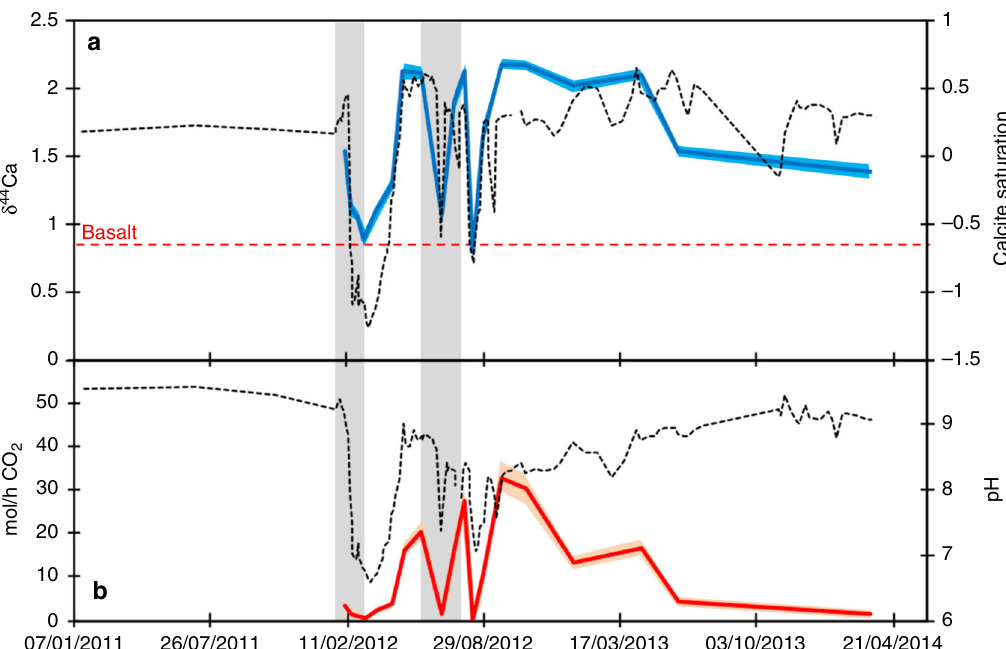
Fig. 3 The trends of the calcite saturation state and Ca isotopes with time during the carbon injection phase from monitoring borehole HN-4. a Ca isotope ratios (blue line) and calcite saturation index (dotted black line). The blue shaded area represents the 2 s.e. analytical uncertainty on the isotope measurements. b shows the evolution of pH (dotted black line) and the calculated CO 2 precipitation rate based on Ca isotopes (red line). The red shaded area represents the 2 σ propagated uncertainty on the individual precipitation rates. The grey shaded areas represent the carbon injection